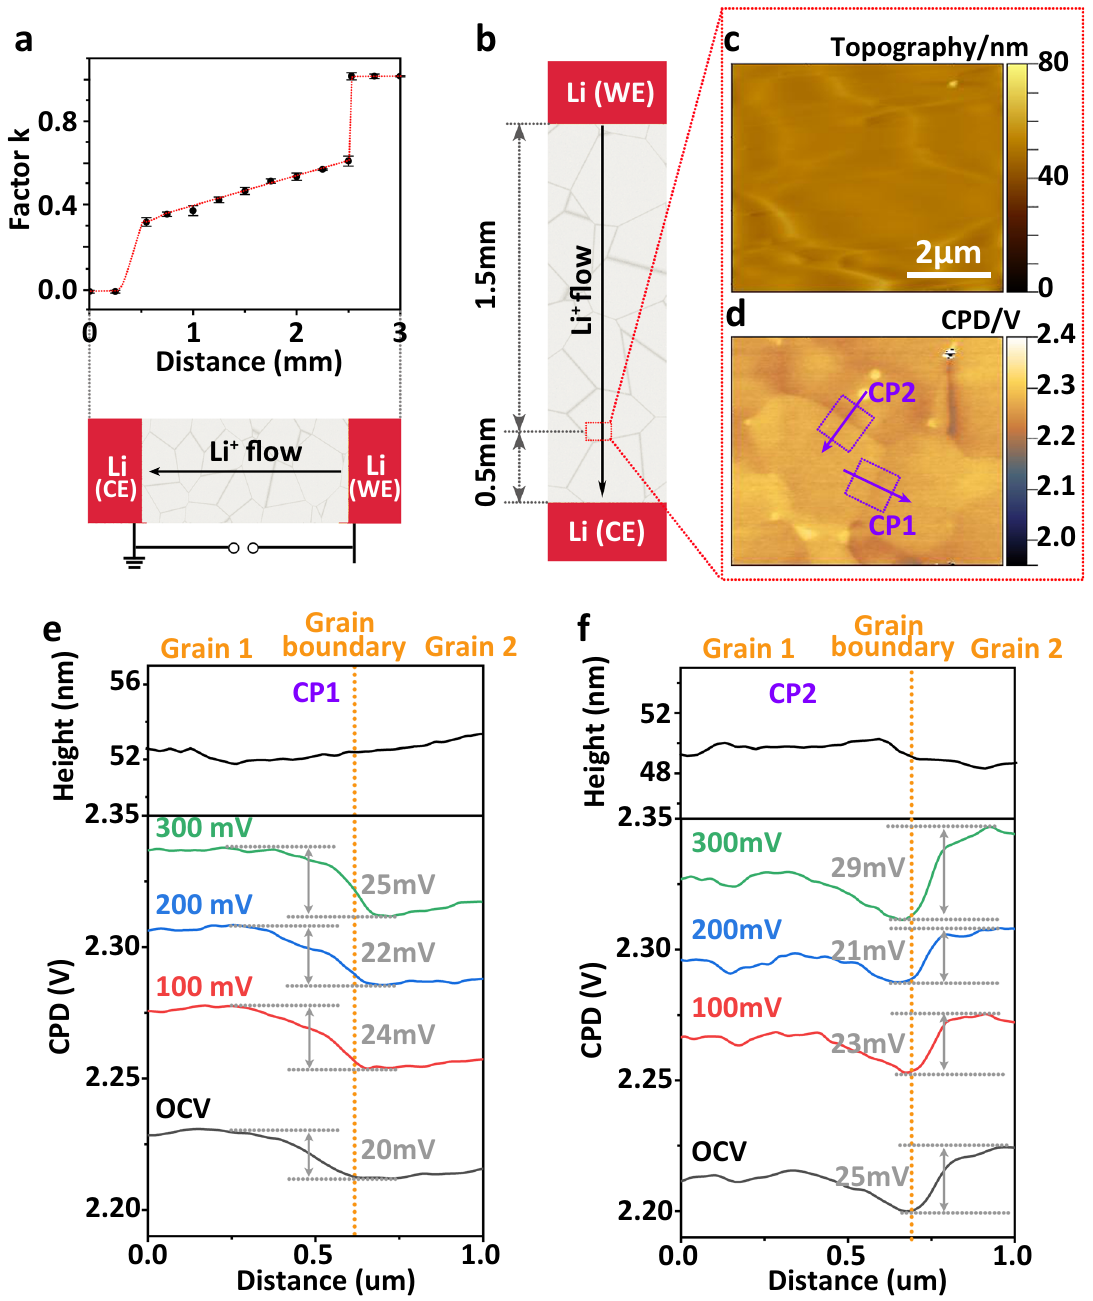
Fig.2|OperandoKPFMmeasurementsonLLZOfarfromelectrode.a Thefactor the LLZO surface. c , d Topography and CPD maps (6 µ m×5 µ m) of the regions k calculated at different points on Li|LLZO|Li surfaces at 300mV potential differ- within the dotted box in b in an OCV state. e , f Averaged line pro fi les of the encebetweenthetwoelectrodes.Theerrorbarscorrespondstothreeindependent topographyandCPDextractedfromareasCP1andCP2inthedirectionofthearrow experiments. b Schematic diagram of the position of the KPFM measurement on under different potentials applied to the WE, about 40mV lower CPD value than in-grain areas (Fig. 3c and Sup- void corresponds to τ values of (296±40) ms, and all other areas plementary Fig. 17). The voids show CPD values some 100 to 200 mV correspond to values of (166 ±20) ms. In particular, there is no dif- lower than in-grain areas. We attribute these lower CPD values to a ferencebetween the grain boundary and the in-grainarea (Fig. 3e). For Li 2 CO 3 layer that formed in voids during prolonged storage of LLZO example, theamplitudeshiftvstimedependenceof threepointsatthe samples or during the sintering process (Supplementary Fig. 18). in-grain region P 1 , the grain boundary P 2 and the defect/void P 3 are plotted in Fig. 3e. The changes in measured amplitude as a function of The tr-EFM measurement was performed in an area of 400nm× timeoverlapatP 1 andP 2 .Thus,weconcludethatgrainboundariesnear 200 nm marked by a purple rectangle in Fig. 3c. This area was uni- the Li-CE and the in-grain areas in LLZO show similar ionic con- formly divided into 20 ×10 pixels. At each pixel, we fi tted the SFM tip ductivity. In other words, grain boundaries do not provide faster or amplitude change at the secondary resonance frequency vs. time with slower ion conduction channels in the LLZO solid electrolyte investi- a stretched-exponential function to obtain the lithium-ion relaxation gated here (i.e., Li 6.25 Al 0.25 La 3 Zr 2 O 12 ). However, the amplitude time constant τ (Fig. 3d) (more details in the Methods section). The